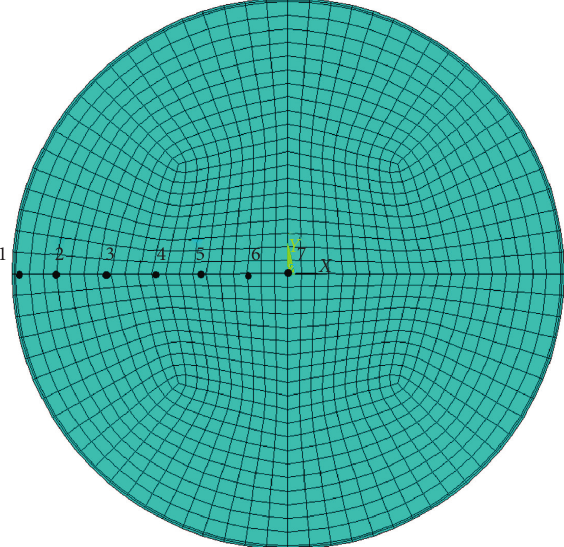
Figure 11: Measuring-point locations of the finite element model.